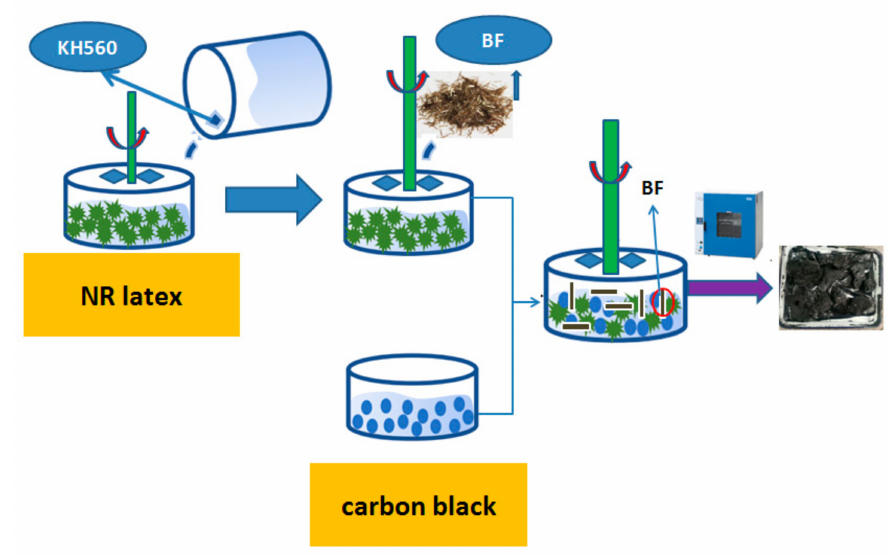
Figure 4. Preparation of rubber and carbon black composites in wet mixing.